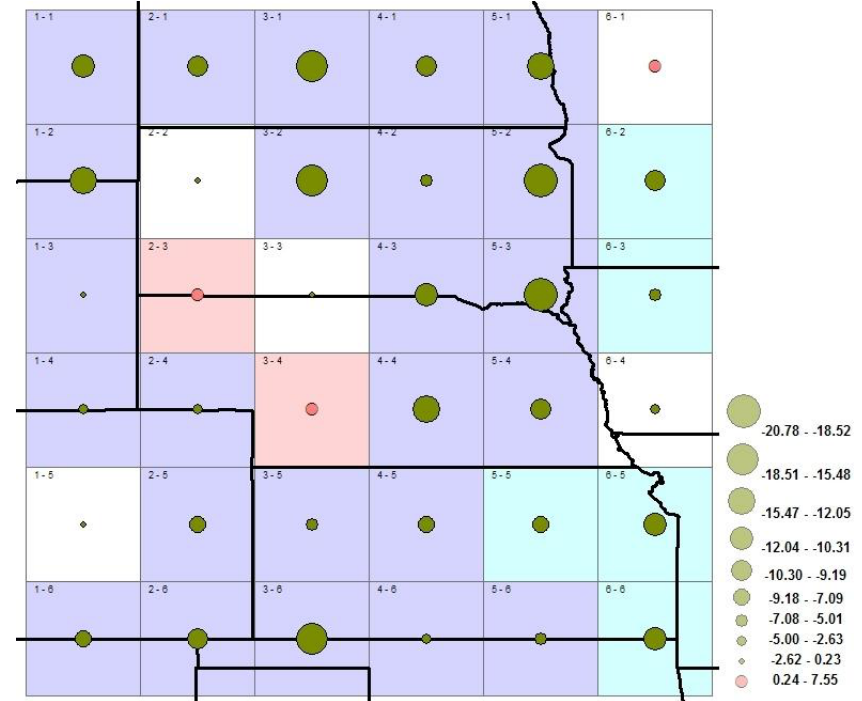
Figure 4. Spatial signatures of climate response to NDVI effect on the High Plains’ regional climate. Blue grids indicate areas with significant cooling signal, white grids indicate areas with insignificant NDVI signal, and light blue grids indicate areas with significant cooling signal from one-signal pattern model. Red grids indicate areas with significant warming signal. The solid green and red circles represent the magnitude of the amplitudes of NDVI signal in each